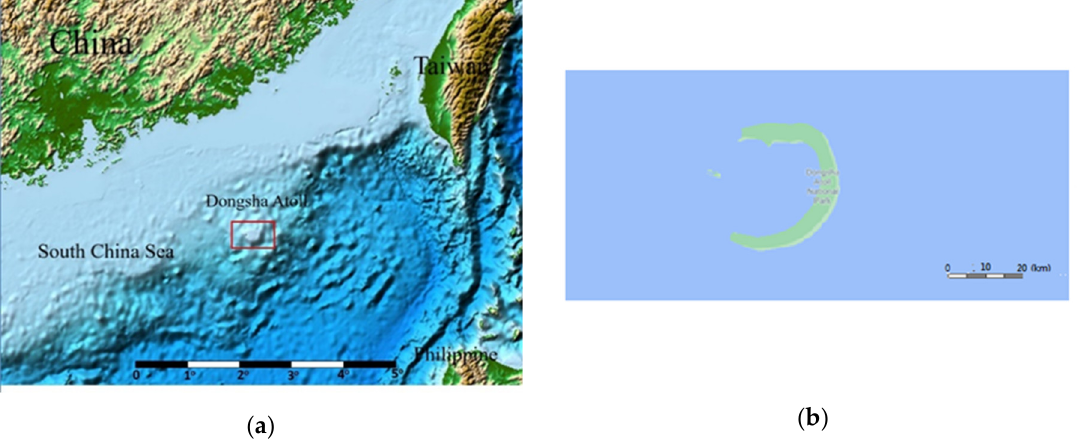
Figure 9. ( a ) Location of Dongsha Atolls and the surrounding water. (Source from ETOPO1 [60]), ( b ) Study area and map of Dongsha Island. (Source from Google Maps [61]).